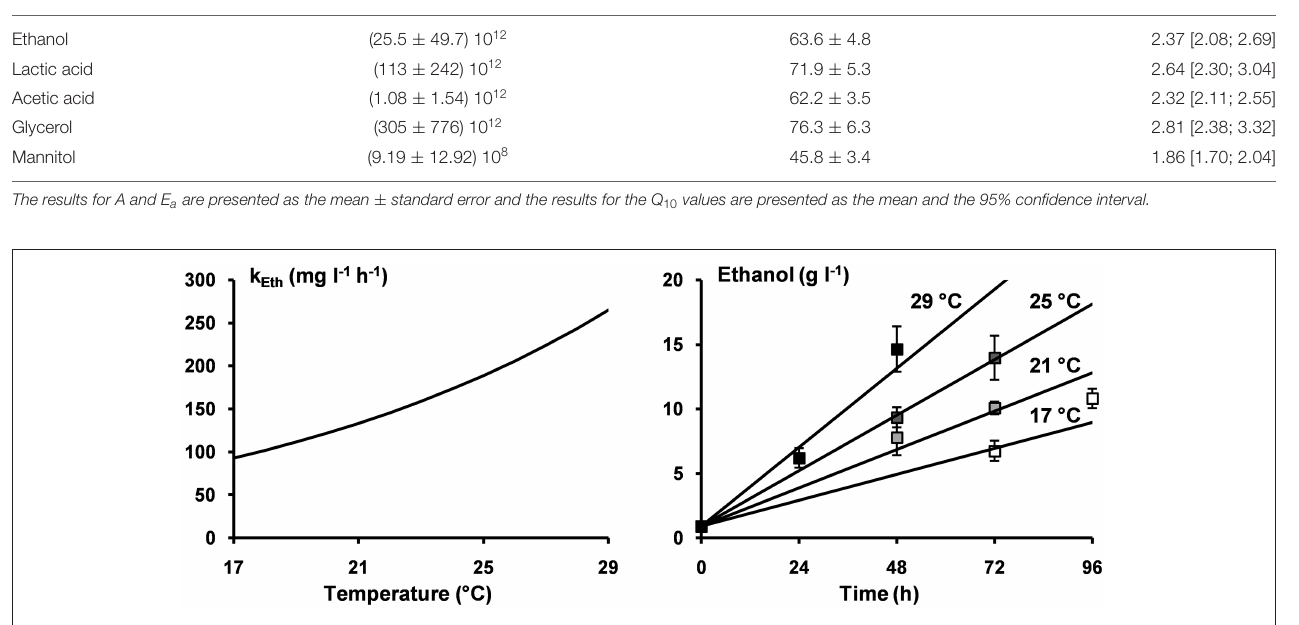
FIGURE 5 | Arrhenius equation describing the volumetric production rates for the production of ethanol (k Eth ) as a function of the incubation temperature (left); the concentrations of ethanol after 72 and 96h of incubation at 17 ◦ C ( (cid:3) ), after 48 and 72h of incubation at 21 ◦ C ( ), after 48 and 72h of incubation at 25 ◦ C ( ), and after 24 and 48h of incubation at 29 ◦ C ( (cid:4) ) (right); and the model lines (solid lines) describing the concentrations of ethanol at incubation temperatures of 17, 21, 25, and 29 ◦ C